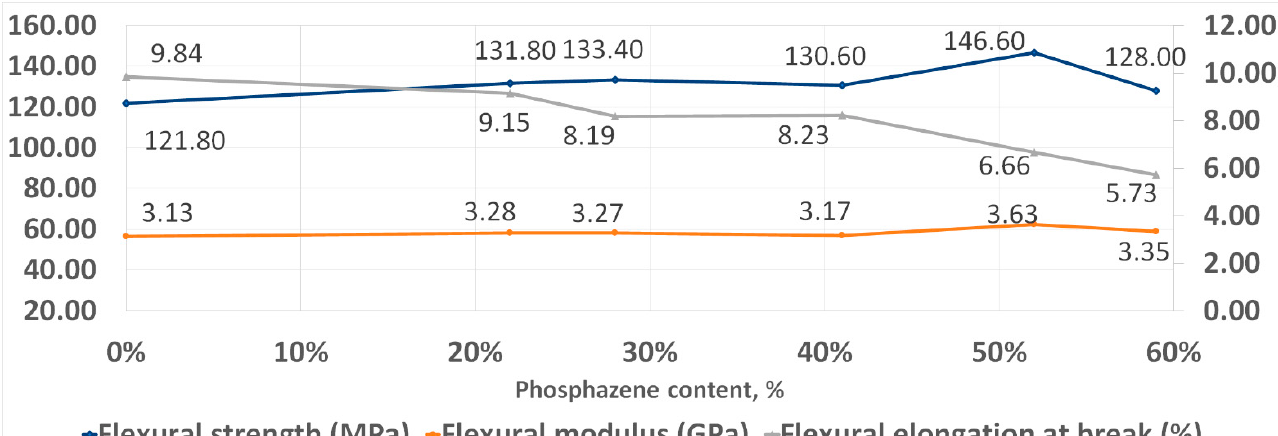
Figure 9. Flexural strength properties of cured resins.